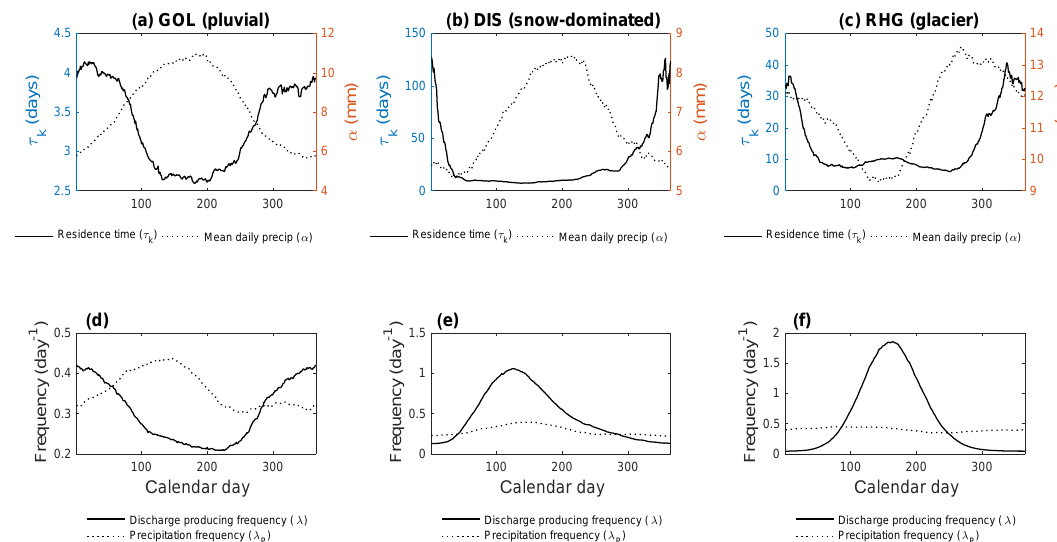
Figure 4. Examples of the temporal variation of the model parameters over the course of a year. The parameters are calculated for 90-day intervals beginning at the calendar day for which the value is plotted; for a given time window, the data points corresponding to this window in all available civil years are pooled together. ( a–c ) Residence time τ k and mean daily precipitation depth α . ( d–f ) Precipitation frequency λ p and discharge-producing frequency λ .